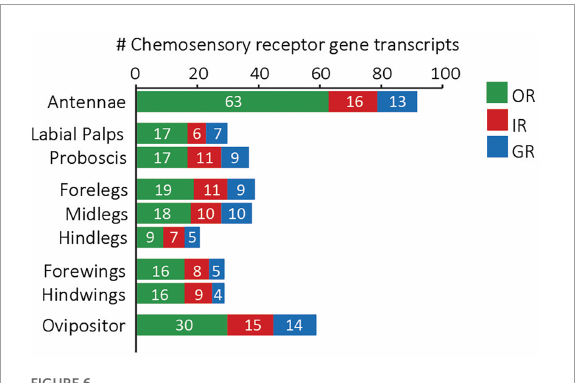
FIGURE6 Number of chemosensory receptor gene transcripts expressed in different tissues of adult M. sexta